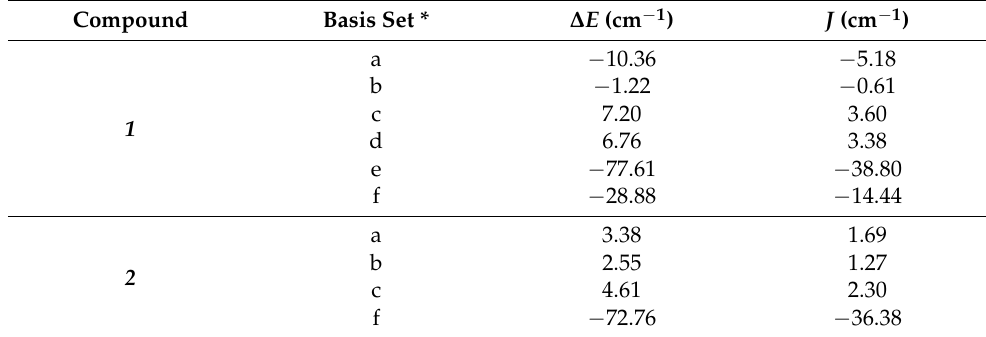
Table 6. Calculated values using the Broken Symmetry Approach of the Exchange Coupling Constants for complexes 1 and 2 . In the second column, the J values are given according to H = − 2JS 1 S 2 . Compound Basis Set * ∆ E (cm − 1 ) J (cm − 1 ) a − 10.36 − 5.18 b − 1.22 − 0.61 c 7.20 3.60 1 d 6.76 3.38 e − 77.61 − 38.80 f − 28.88 − 14.44 3.38 2 −